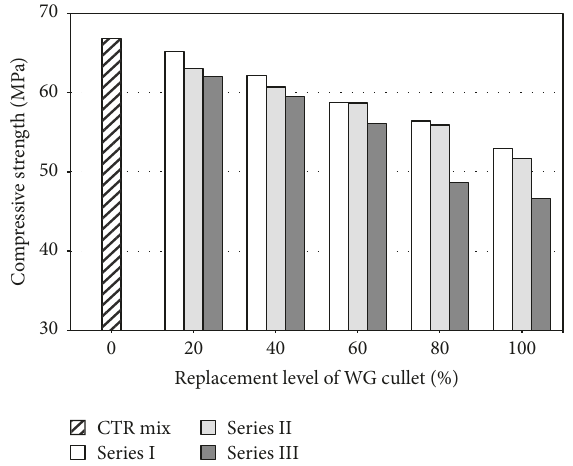
Figure 4: The reduction in compressive strength according to the content of WG cullet